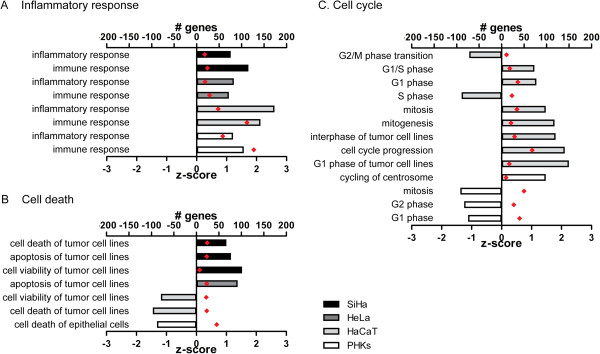
Effect of CDV exposure on functions related to inflammatory response (A), cell death (B), and cell cycle (C). The regulation z-score predicts whether an identified biological function is activated or inhibited. Positive z-scores indicate activation of a biological function, while negative z-scores suggest an inhibition. Absolute z-score values above 1 are considered significant. All identified functional annotations are represented in Additional file 2: Figure S2.